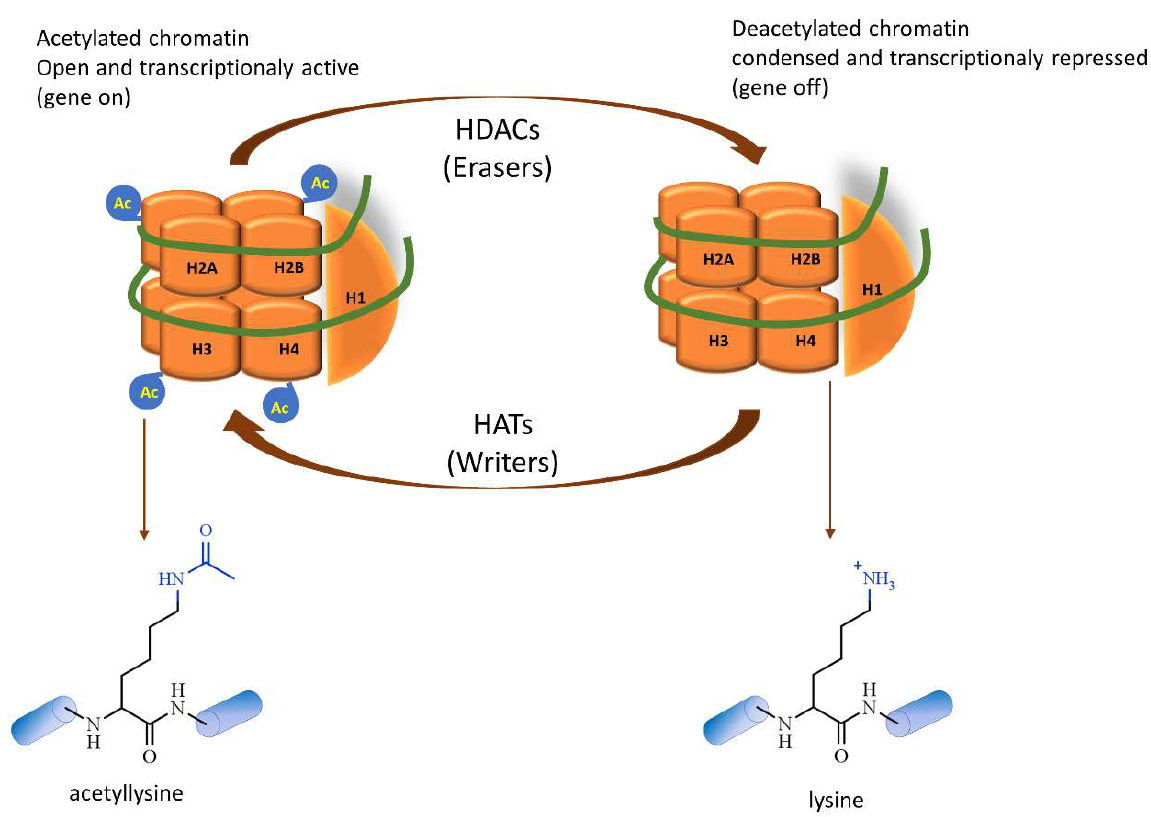
Figure 1. Overview of acetylation/deacetylation of histone lysine residues. The acetylation of lysine (Lys) residues catalyzed by histone acetyltransferases (HATs) induces decondensed chromatin and transcriptionally active DNA. In contrast, the histone deacetylases (HDACs) remove acetyl (Ac) residues and provoke condensed chromatin and repression of DNA transcription.